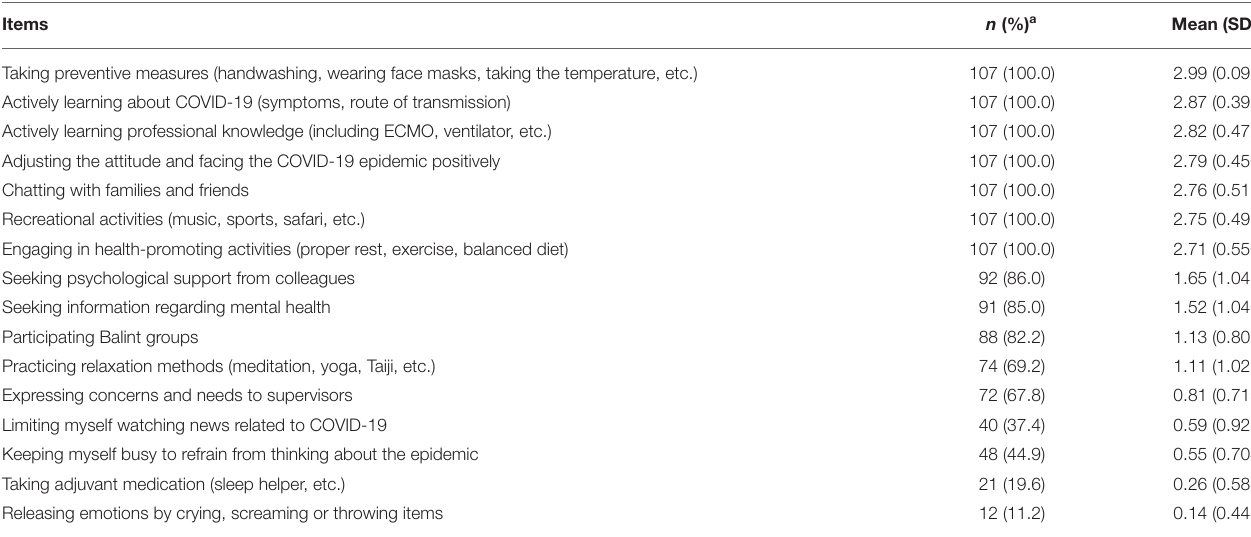
TABLE 3 | Coping strategies ( n =